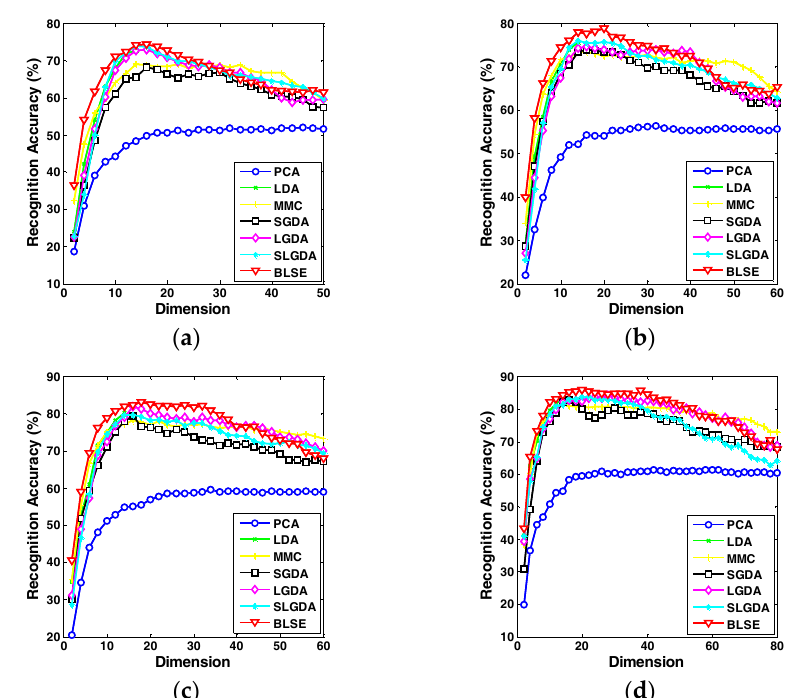
Figure 9. Recognition rate (%) versus dimension of different methods on the ORL database. ( a ) Three training samples per person; ( b ) Four training samples per person; ( c ) Five training samples per person; ( d ) Six training samples per person.